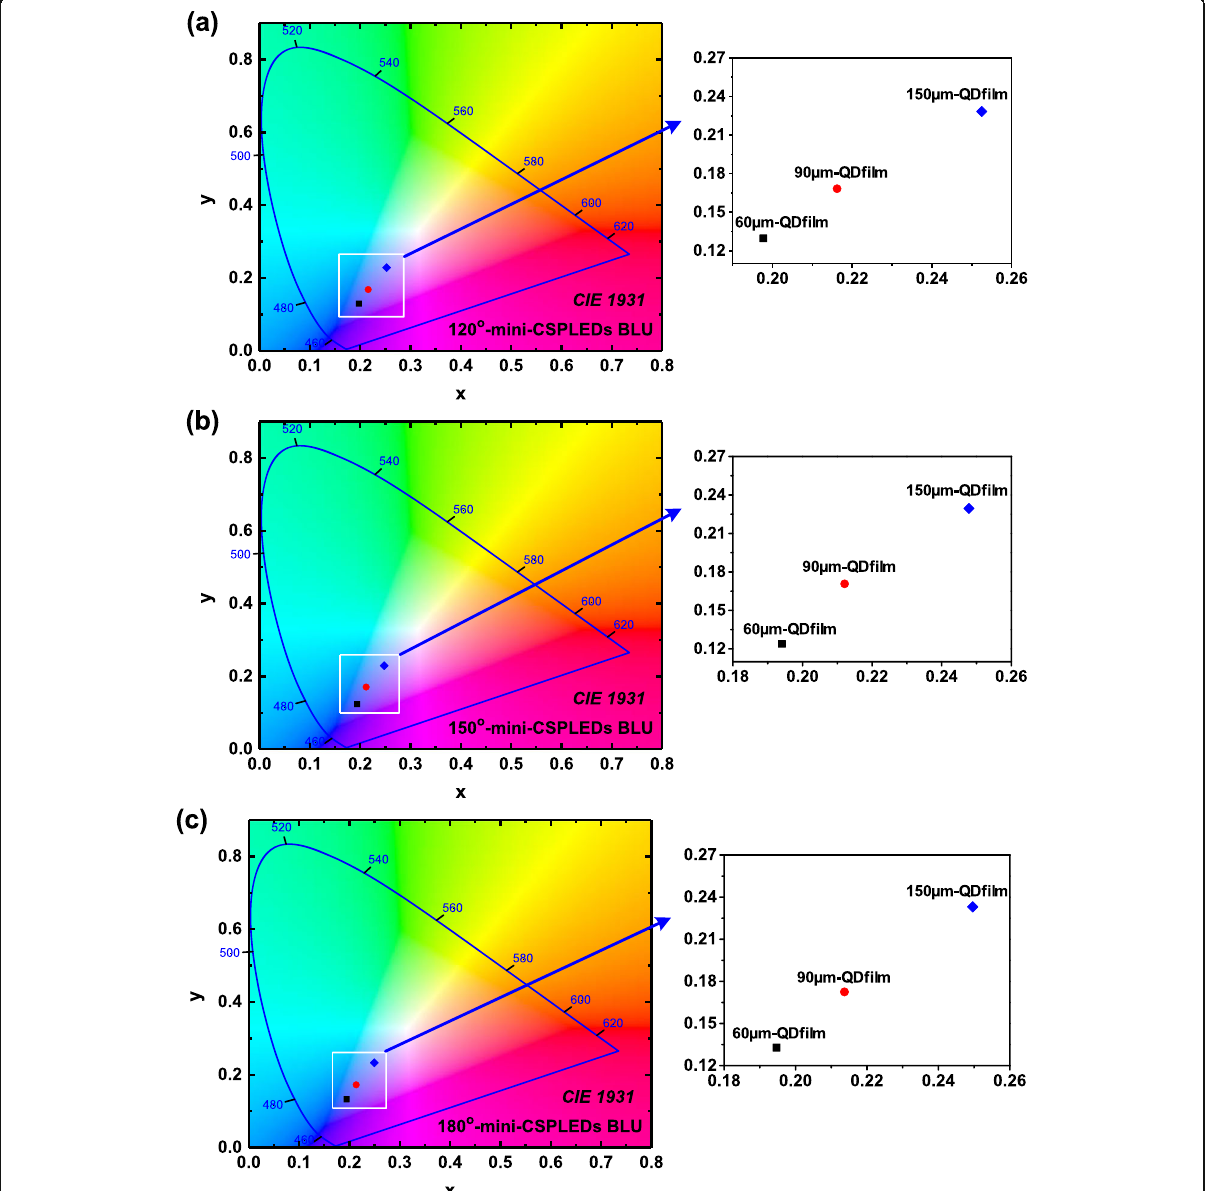
Fig. 6 CIE chromaticity diagrams of 120° mini-CSPLED BLU, 150° mini-CSPLED BLU, and 180° mini-CSPLED BLU with different QD film thickness